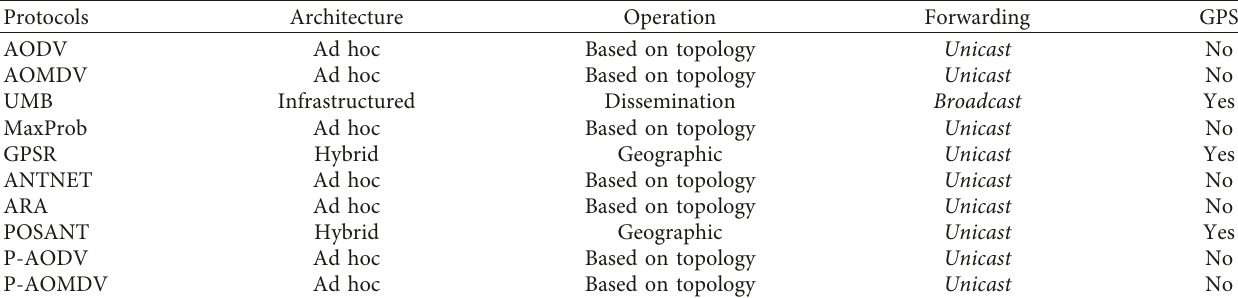
Table 5: Routing protocols: comparative